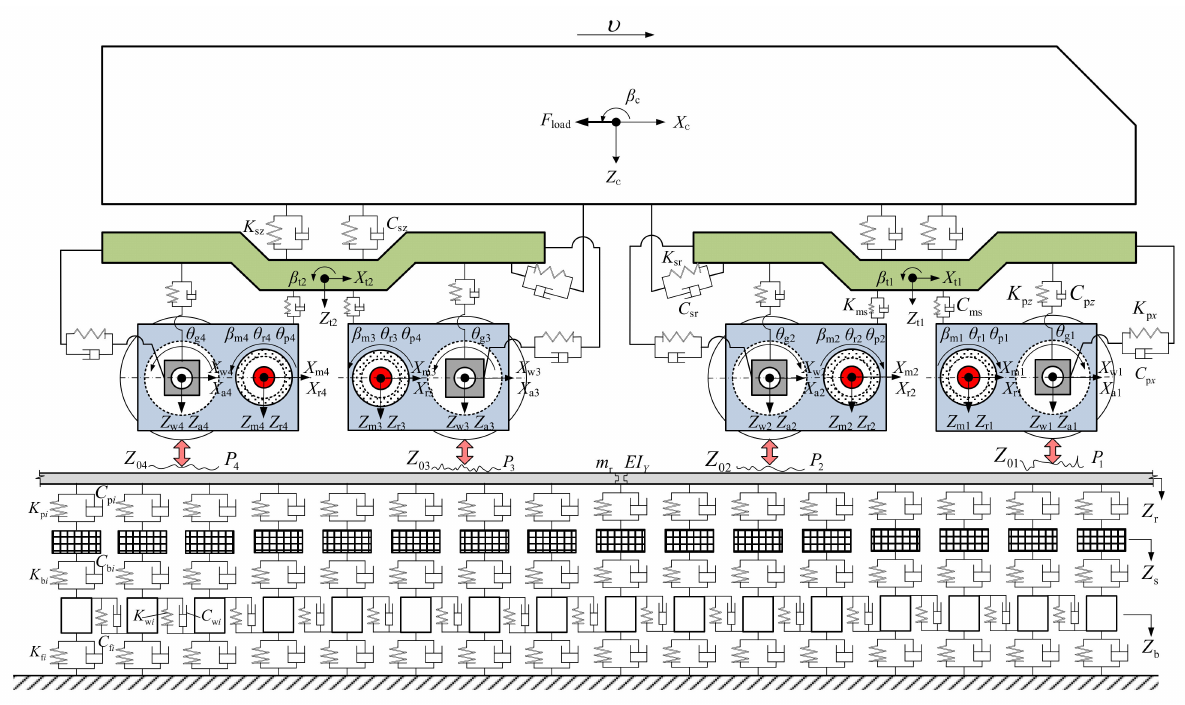
Figure 1. Schematic of